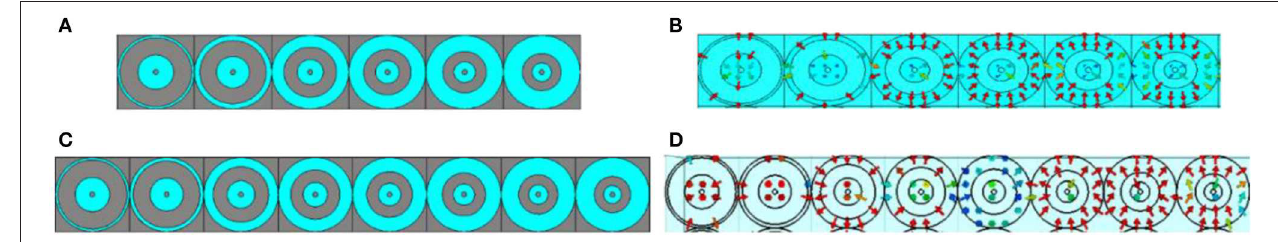
FIGURE 4 | (A) The π /3 phase increment at two adjacent units along the x -axis. (B) The current distribution of the six-element. (C) The π /4 phase increment at two adjacent unit along the x -axis. (D) The current distribution of the six-element and eight-element.